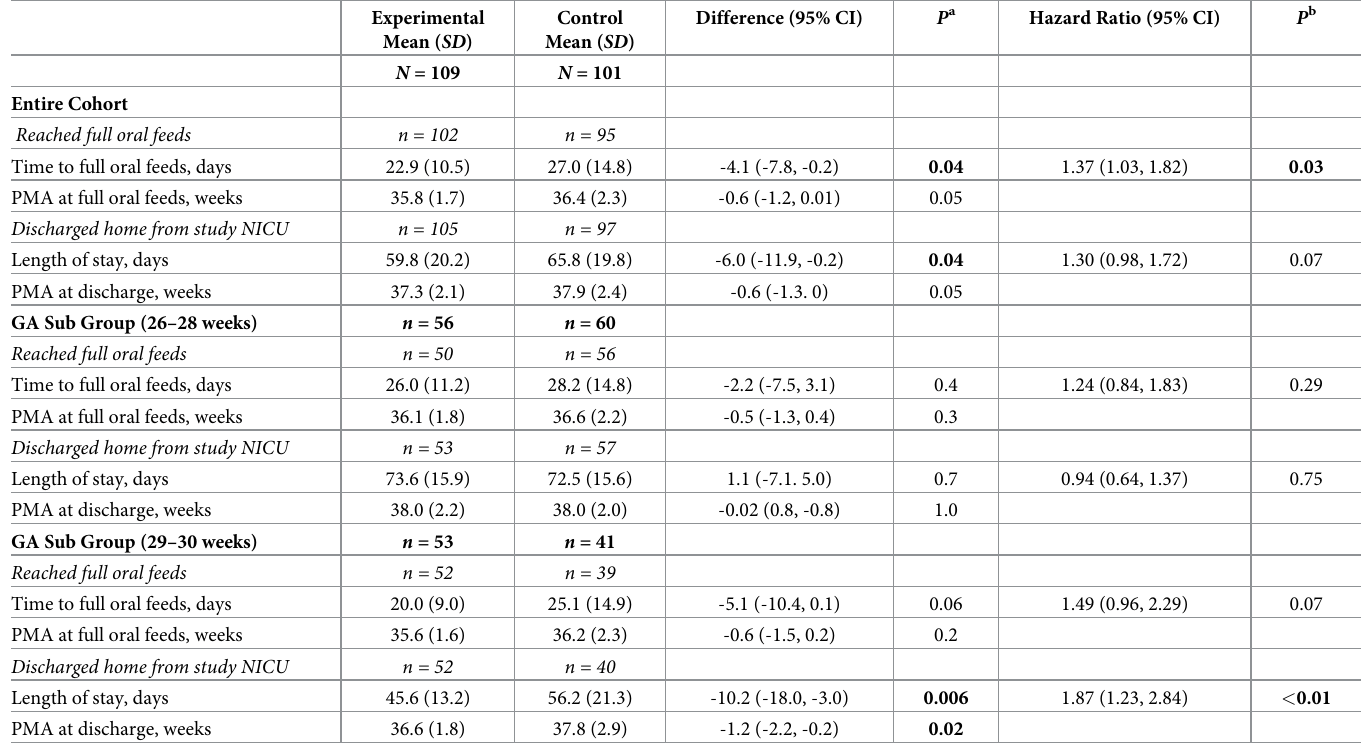
Table 2. Study outcomes.